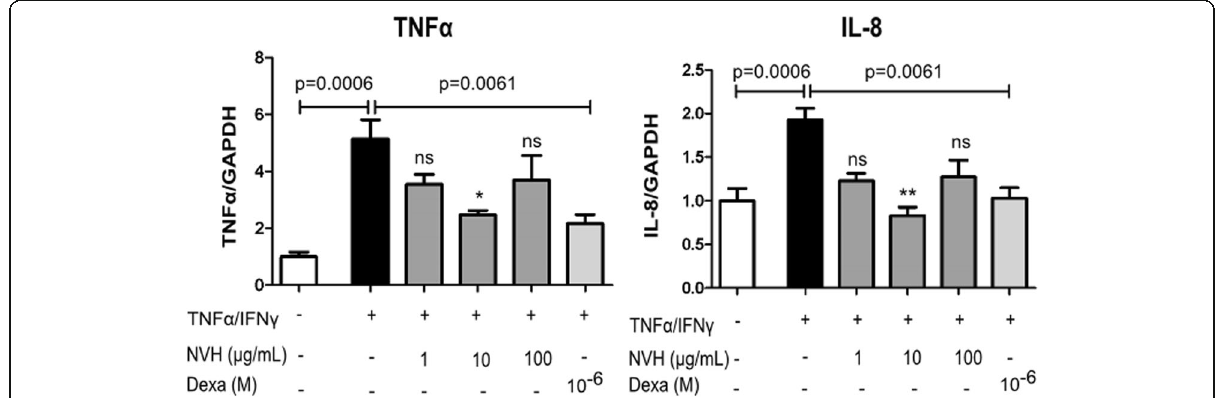
Fig. 5 Pro-inflammatory cytokine expression in cells. Cells were stimulated or not (control) with TNF α /IFN γ , and then treated 24 h later with varying extract concentrations (1, 10 and 100 μ g/mL) or with dexamethasone (10 − 6 M). All experiments were performed in triplicate. Bar graphs represent cytokine expression in cells. The left panel represents TNF α and the right panel IL-8. Data are expressed as mean ± Standard Error of the Mean. Significant Dunn ’ s post tests are indicated as * p < 0.05; ** p < 0.01; *** p < 0.001; ns: non-significant. The p -value indicates the Mann-Whitney test. NVH: Neoboutonia velutina aqueous extract; Dexa: Dexamethasone; TNF α : Tumor Necrosis Factor alpha; IFN γ : Interferon gamma; IL-8: Interleukin-8; GAPDH: Glyceraldehyde-3-Phosphate